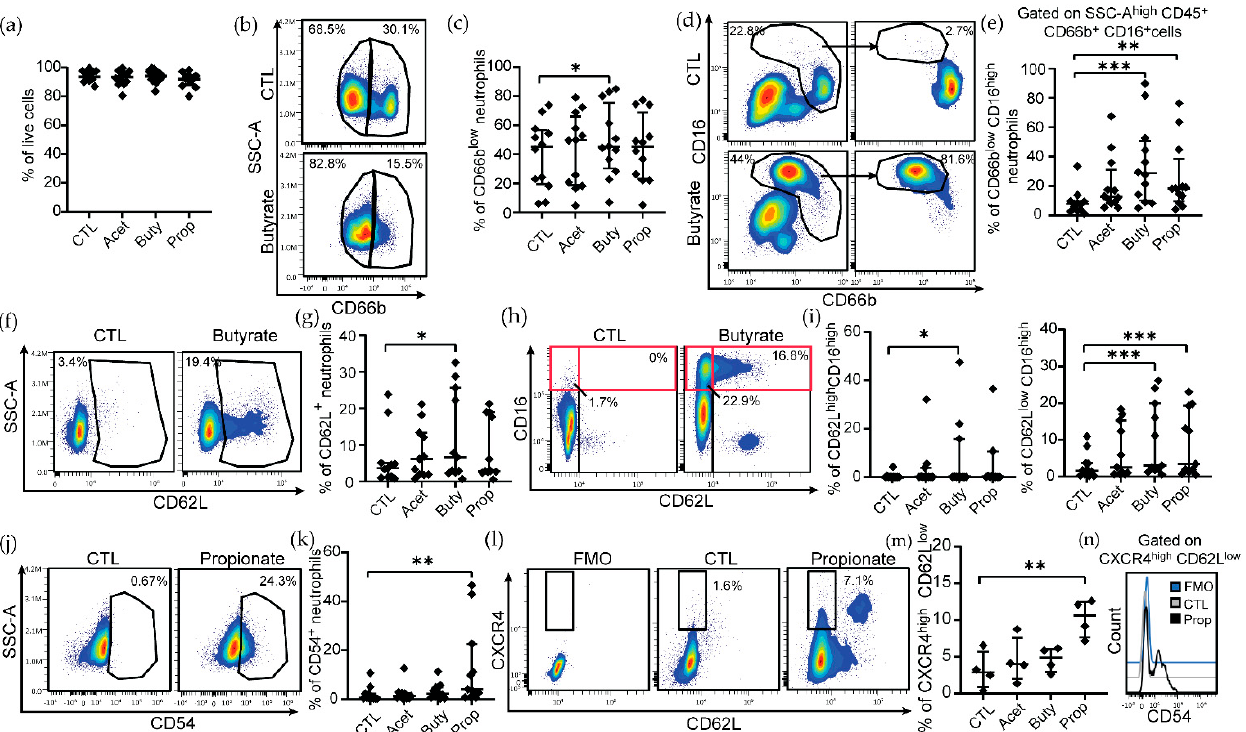
Figure 1. High concentrations of butyrate and propionate induce phenotypical changes in human neutrophils. ( a ) Quantification of cell death induced by high concentration of SCFA ( n = 12). ( b ) Representative example of flow cytometry plots showing CD66b expression on neutrophils in control condition (CTL) and after butyrate treatment (25 mM) for 3 h. ( c ) Percentage of CD66b low neutrophils after treatment with SCFAs (acetate, butyrate, and propionate) 25 mM for 3 h ( n = 12). ( d ) Representative example of flow cytometry plots and ( e ) percentage of CD66b low CD16 high neutrophils after SCFA treatment ( n = 12). ( f ) Flow cytometry plots and ( g ) changes in percentage of CD62L + neutrophils induced by SCFAs. Effect of pathological concentration of SCFAs on (( h , i ); n = 11) CD16 high CD62L high or CD62L low neutrophil population and ( j , k ) CD54 + neutrophils ( n = 11). ( l ) Representative flow cytometry plots and ( m ) quantification of the percentage of CXCR4 high CD62L low neutrophils after treatment with pathological concentration of SCFAs ( n = 4). ( n ) Changes induced by propionate treatment in CD54 expression of neutrophils gated on CXCR4 high CD62L low population. Each dot represents a different patient (age of patients: 18–72 years old). Non-parametric paired Friedmann test was used, * p ≤ 0.05, ** p ≤ 0.01, *** p ≤ 0.001. CTL: control; Acet: acetate 25 mM; Buty: butyrate 25 mM; Prop: propionate 25